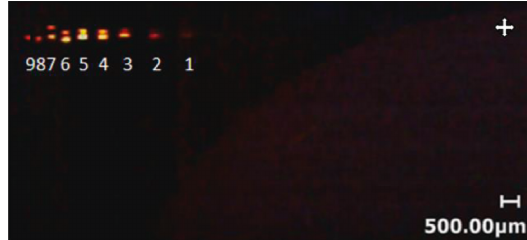
Figure 10: The flight path of two frictional sparks of